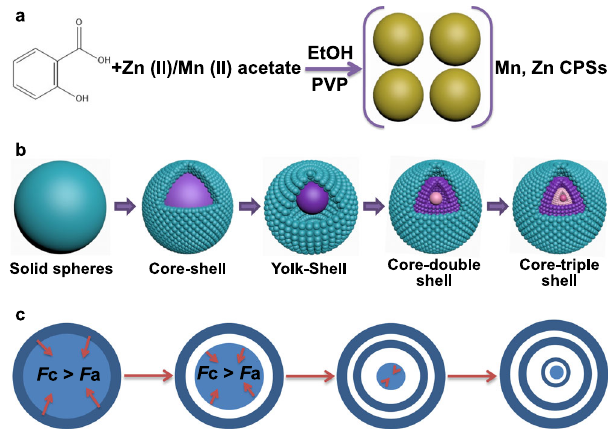
Fig. 1 Schematic illustration of Mn, C-ZnO CTHSs formation process. a Preparation of Mn, Zn-CPSs from solvothermal treatment of zinc acetate and manganese acetate with salicylic acid in the presence of PVP. b Step- by-step conversion of Mn, Zn-CPSs into Mn, C-codoped ZnO CTSHSs upon calcination at 550°C for 3 h. c The underlying driving force for such hollow structure